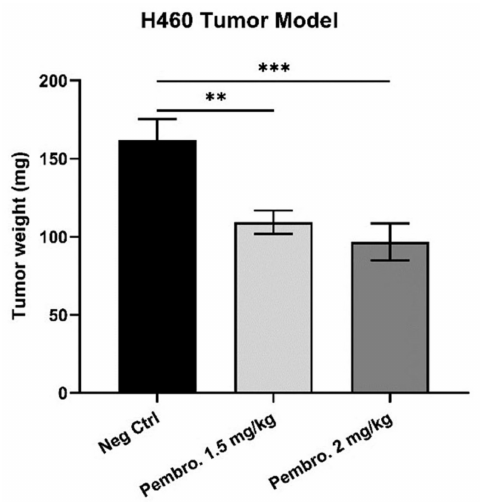
Figure 6. Tumor weights (mean values ± SEM) of in ovo xenografted H460 tumors after treatments with pembrolizumab. Pembro. 1.5 mg/kg vs. Neg Ctrl, p = 0.0065 (**); Pembro. 2.0 mg/kg vs. Neg Ctrl, p = 0.0007